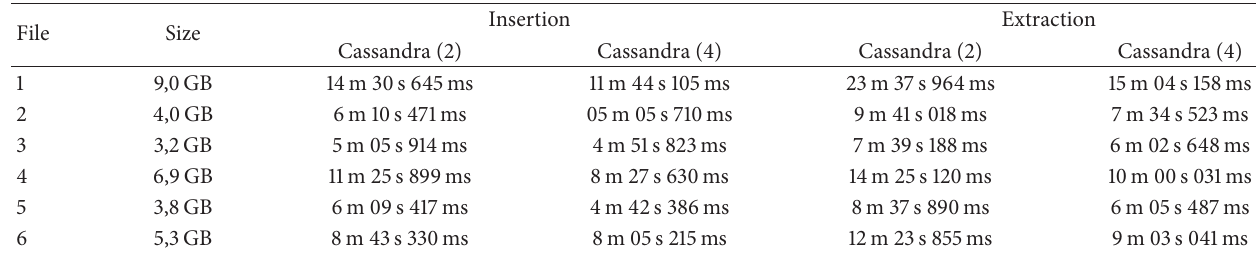
Table 2: Times to insert and extract sequences from the database.